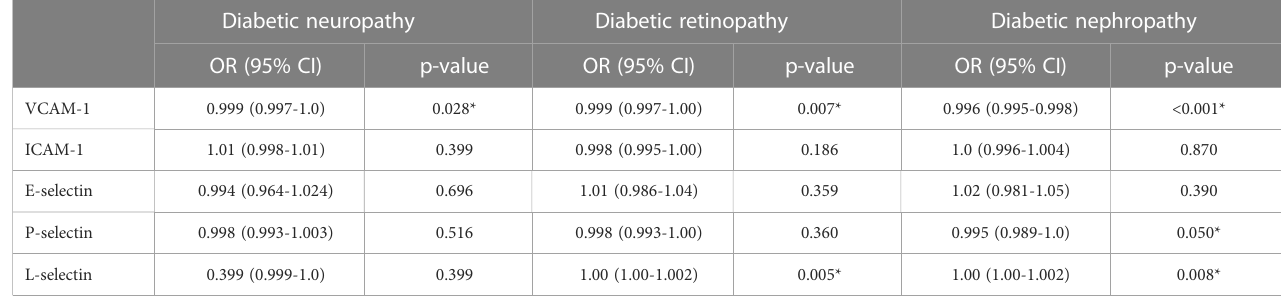
TABLE 3 Multiple logistic regression analysis to determine the association between level of adhesion molecules and selectins with microvascular complications in patients with type 2 diabetes mellitus. Diabetic neuropathy